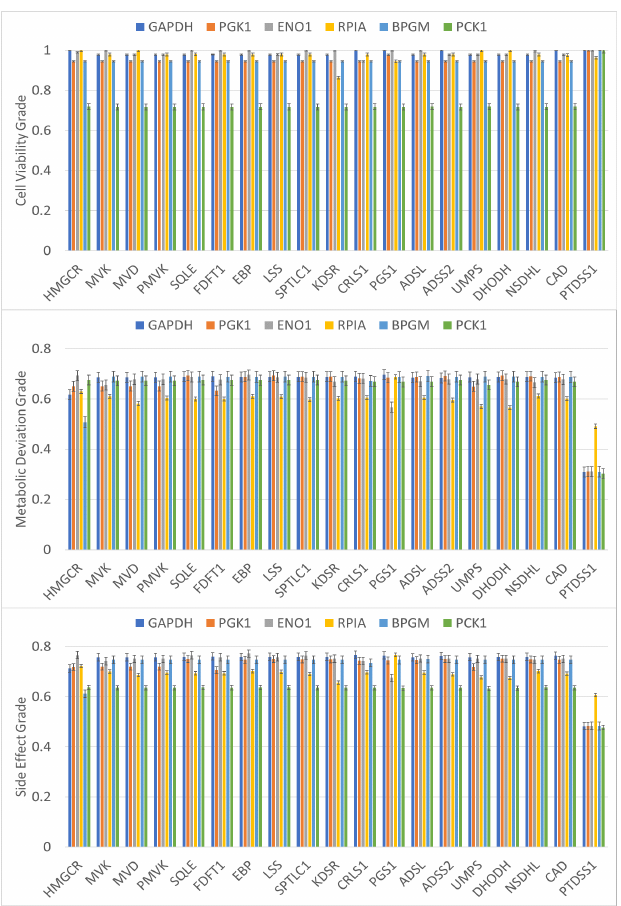
Figure 5. Membership grades for two-target combinations. Membership grades of cell viability ( η CV ), metabolic deviation ( η DV ), and side effect ( η SE ) for two-target combinations of anticancer enzymes for colon cancer treatment. Cancer cell cytotoxicity was observed for each treatment. Therefore, the cell viability grade represents the cell growth viability of normal cells during treatment. Higher metabolic deviation grades indicate that the flux pattern of the perturbed cells was more dissimilar to the cancer template and more similar to the normal template. Higher side effect grades indicate fewer side effects. The numbers of drugs identified from DrugBank acting on each first target are shown in Table 2. The numbers of drugs acting on second targets are listed in brackets as follows: GAPDH (7), PGK1 (6), ENO1 (6), RPIA (1), BPGM (Not Available), and PCK1 (6). Error bar around each estimate was obtained through ten repeated